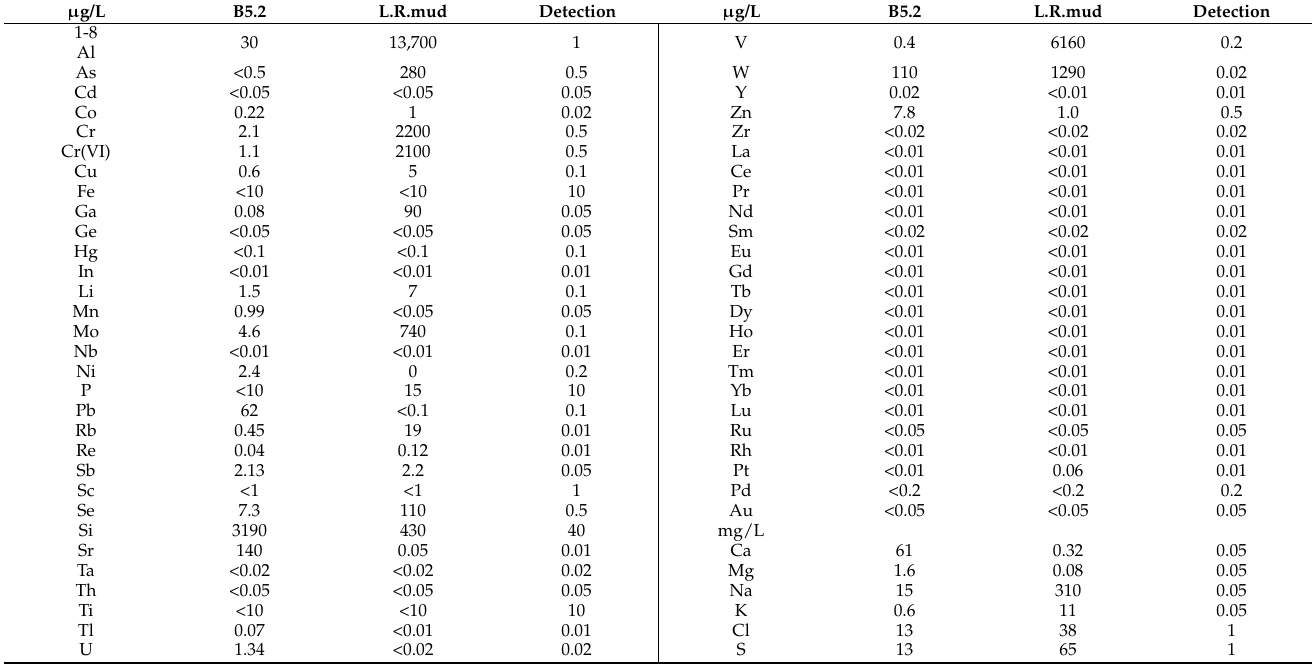
Table 3. Trace element concentration in water leachates from bauxite (B5.2) and red mud (L.R.mud) [23]